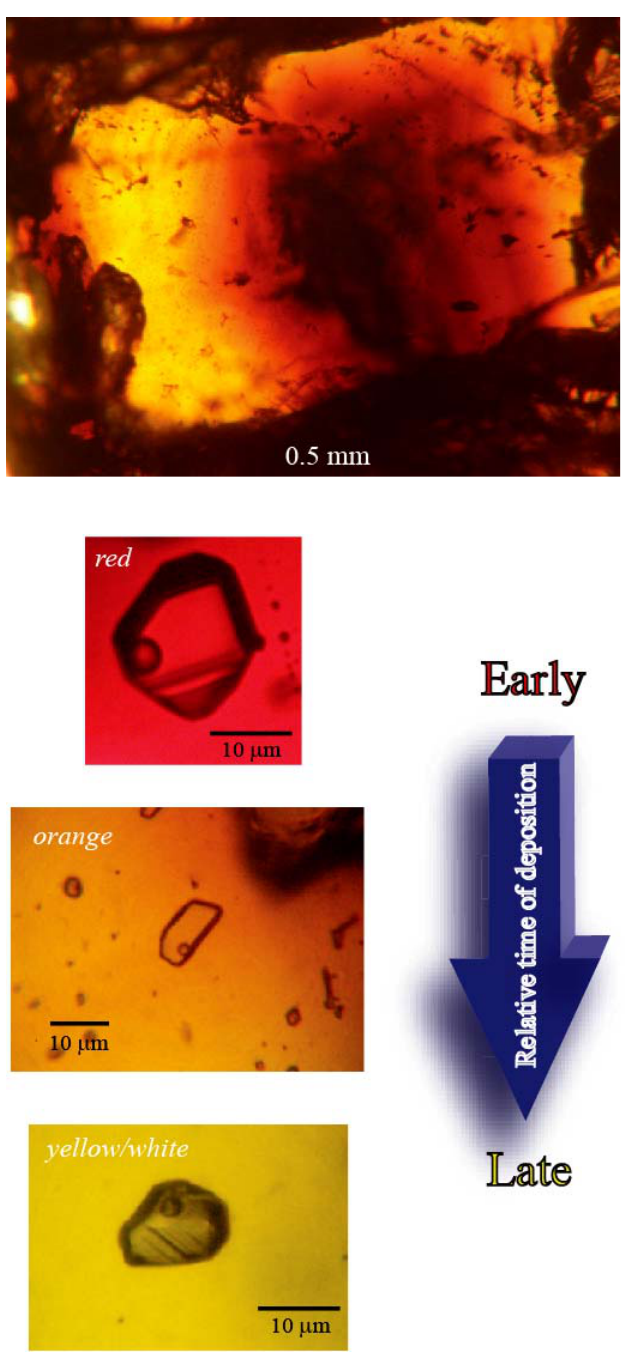
Figure 8. The upper photo shows a zoned sphalerite crystal from Ersmarksberget. The lower three photos show representative aqueous fluid inclusions in the dark red core, the intermediate orange zone and the yellow margin. The arrow indicates the relative time of deposition and decreasing